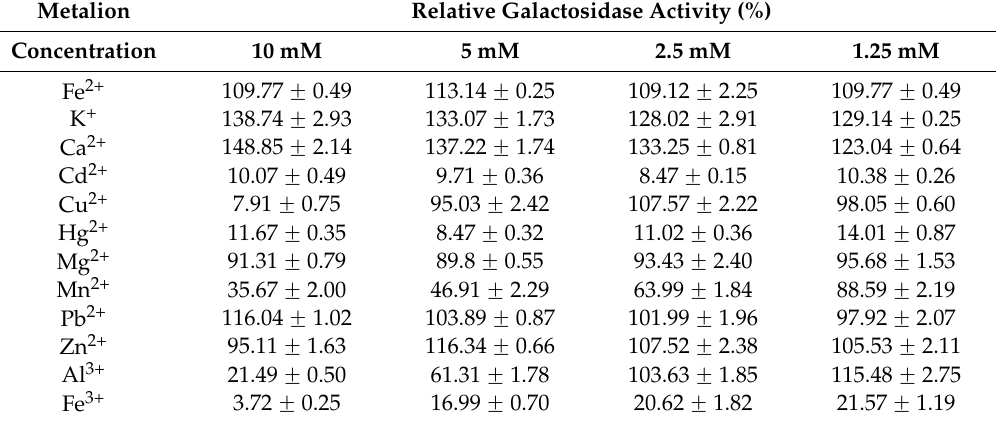
Table 2. Effects of different metal ions on the activity of α -galactosidase (Results represent mean ˘ SD, n = 3).